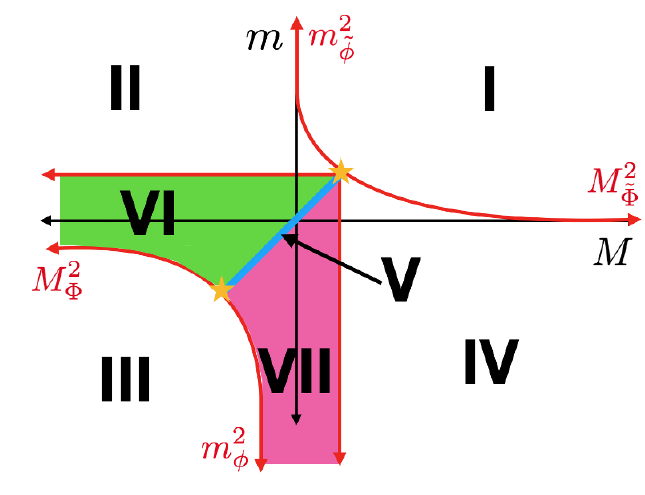
Figure 5 . Phase diagram for (cid:13)avor broken QCD 3 with f; F > k . These phases are laid out in section